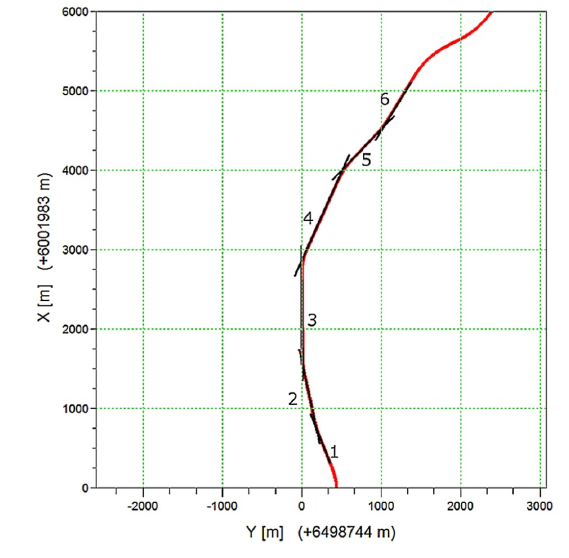
Figure 11: Fragment of the polygon of main directions. Straights no. 1-6 from Table